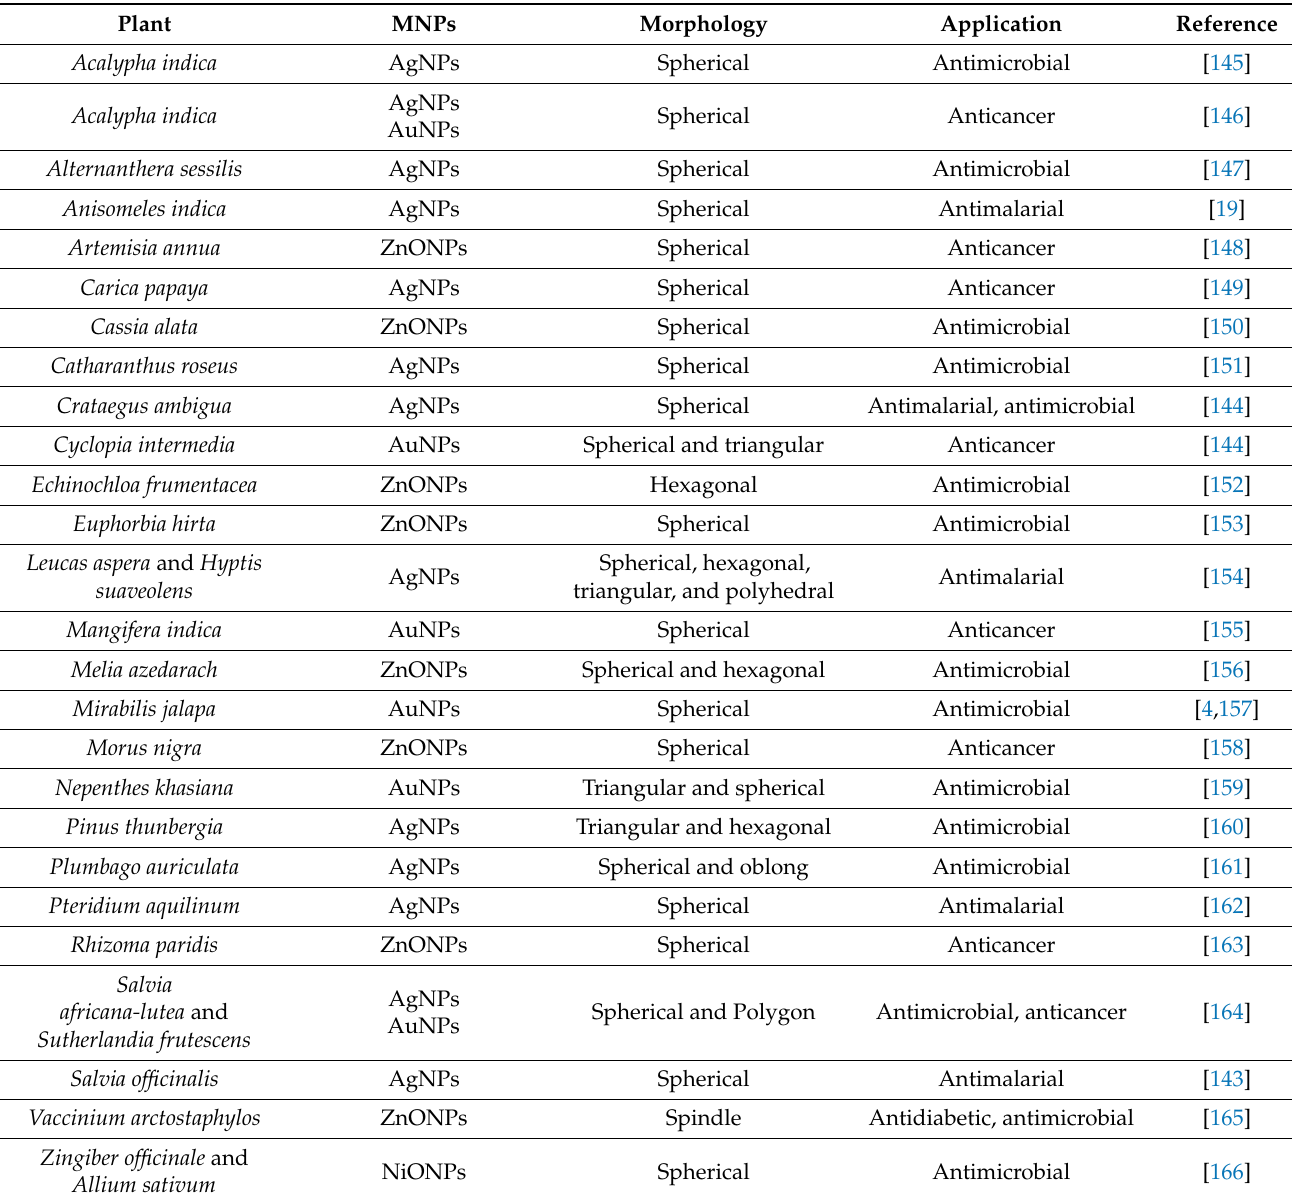
Table 3. Some of the plant species that have been used to synthesize metallic nanoparticles through green